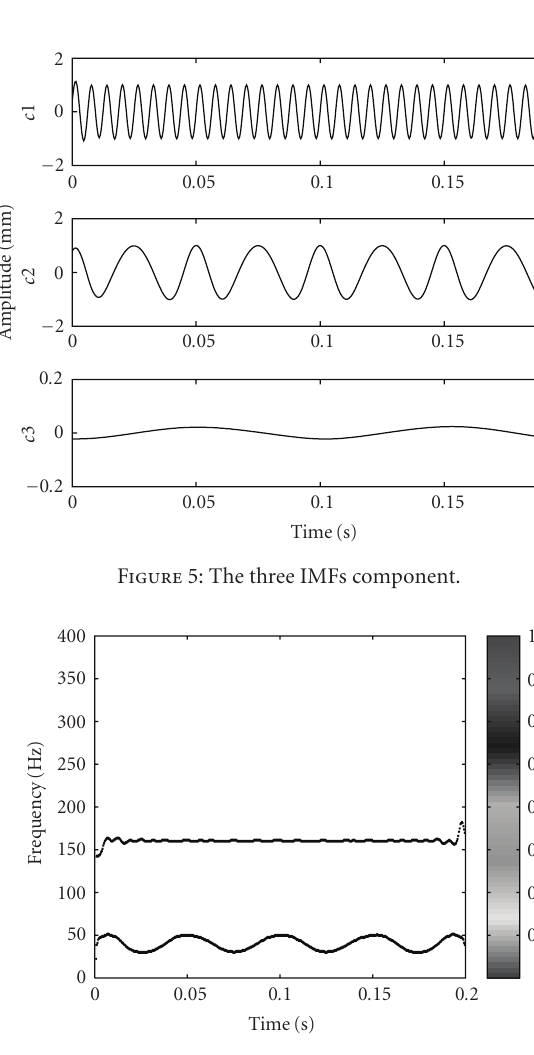
Figure 6: THT spectrum of multicomponent